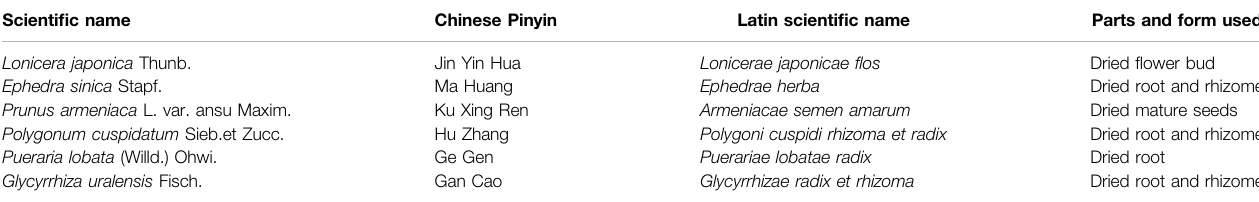
TABLE 1 | Components of YHPG (intervention